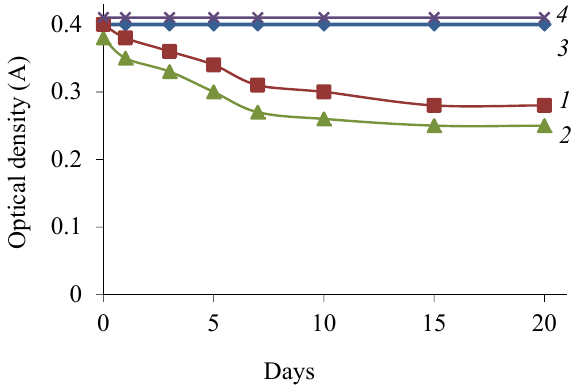
Fig. 10. Change in the color intensity of tarragon aqueous infusions without organic impurities ( 4 ) and those that contain trichlorethylene ( 1 ), dichloroethane ( 2 ) and chloroform ( 3 ) over time.